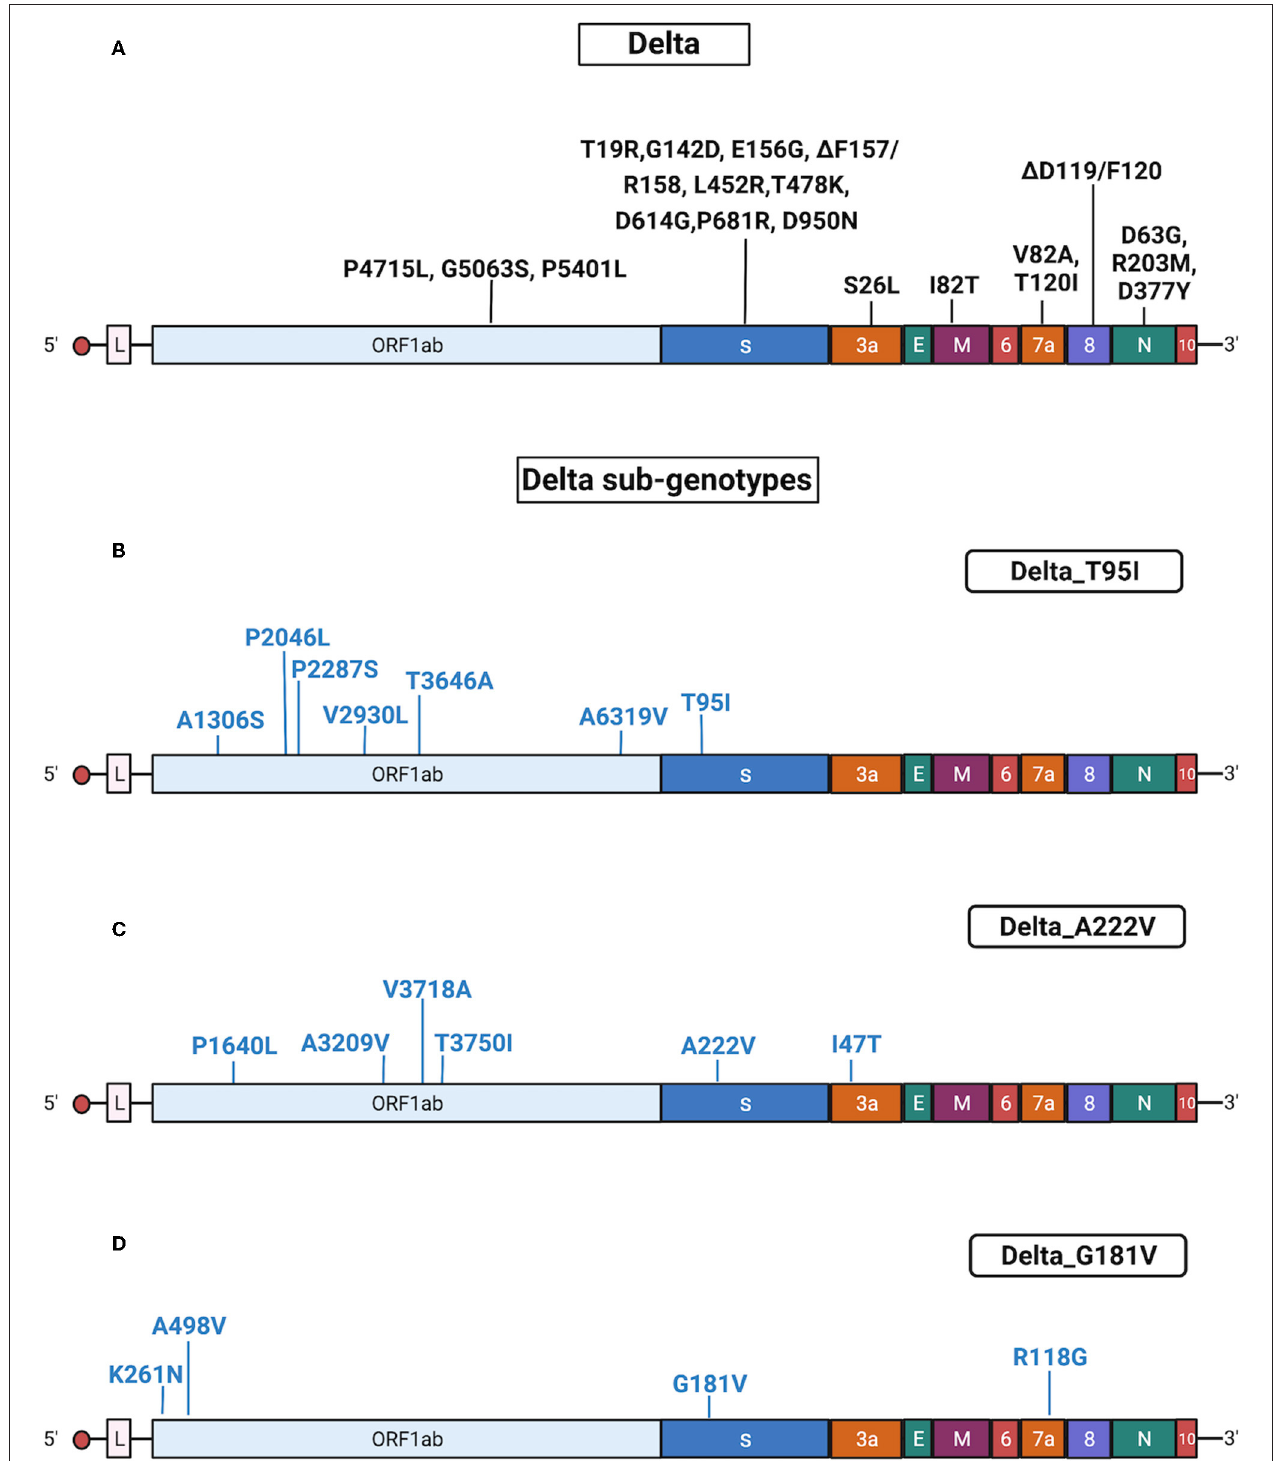
FIGURE 5 | Substitutions in Delta isolates. The figure shows the substitutions identified in the Delta isolates by NGS. Color code: black, substitutions common to all Delta isolates; blue, substitutions specific for the different Delta sub-genotypes. (A) Substitutions common to all Delta isolates. (B) Substitutions identified in all Delta isolates characterized by the presence of T95I (sub-genotype Delta_T95I). (C) Substitutions identified in all Delta isolates characterized by the presence of A222V (sub-genotype Delta_A222V). (D) Substitutions identified in all Delta isolates characterized by the presence of G181V (sub-genotype Delta_ G181V). Gene abbreviations: ORF, open reading frame; S, Spike; E, envelope; M, membrane; N, nucleocapsid. Adapted from “Genome Organization of SARS-CoV” by BioRender.com (2022). Retrieved from